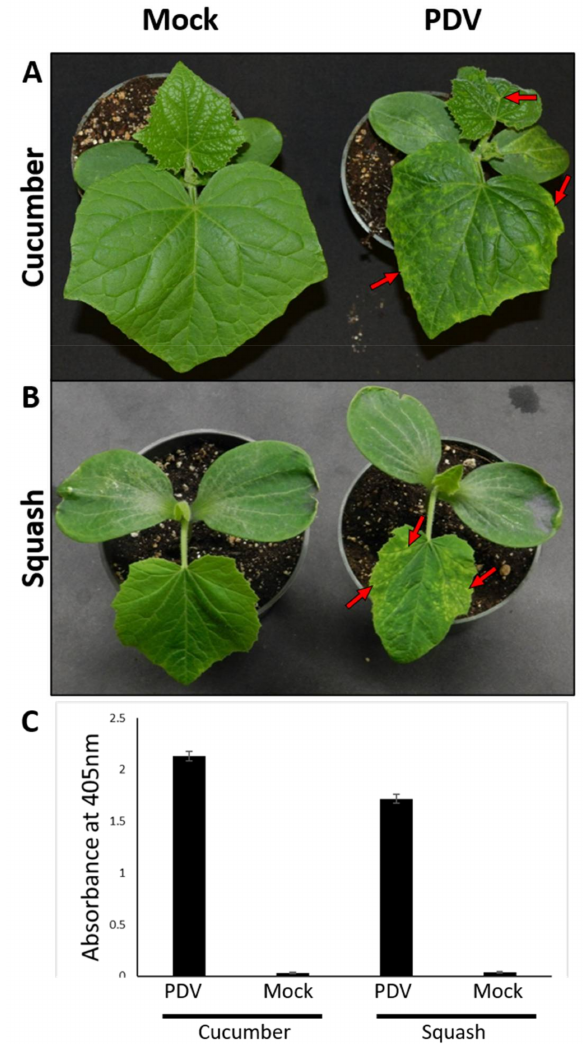
Figure 6. PDV derived from the cDNA clone is mechanically transmissible. The cotyledons of squash and cucumber seedlings were mechanically inoculated with leaf tissues from healthy control plants or with the symptomatic leaves of PDV infected cucumber plants. ( A ) PDV symptoms are clearly seen as chlorotic leaf spots at 9 dpi (red arrows). ( B ) When squash seedlings were mechanically inoculated at 9 dpi chlorotic spots were seen at the margins of the first true leaves (red arrows). ( C ) DAS-ELISA was used to confirm PDV infection and was used to compare relative abundance of PDV at nine dpi. Error bars represent the standard deviation of the mean. Studies on mechanical transmission were performed as three independent experiments each consisting of 5 seedlings of each species for each treatment during each experiment. In all experiments, no positive results were obtained by DAS-ELISA from mock inoculated